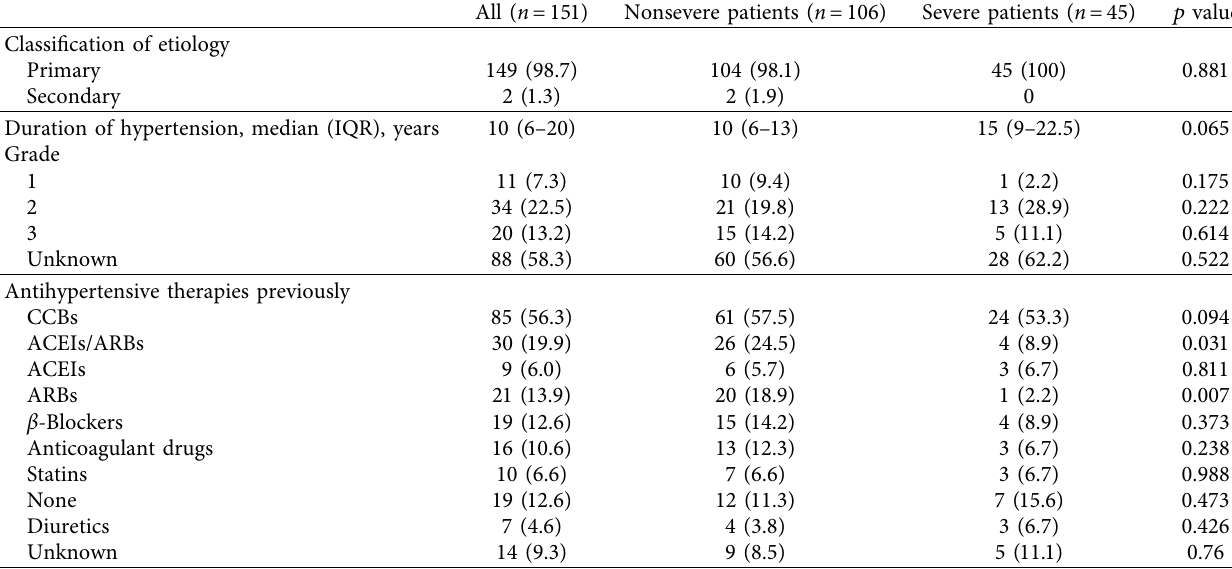
Table 3: Antihypertensive treatments of patients with COVID-19 and hypertension.